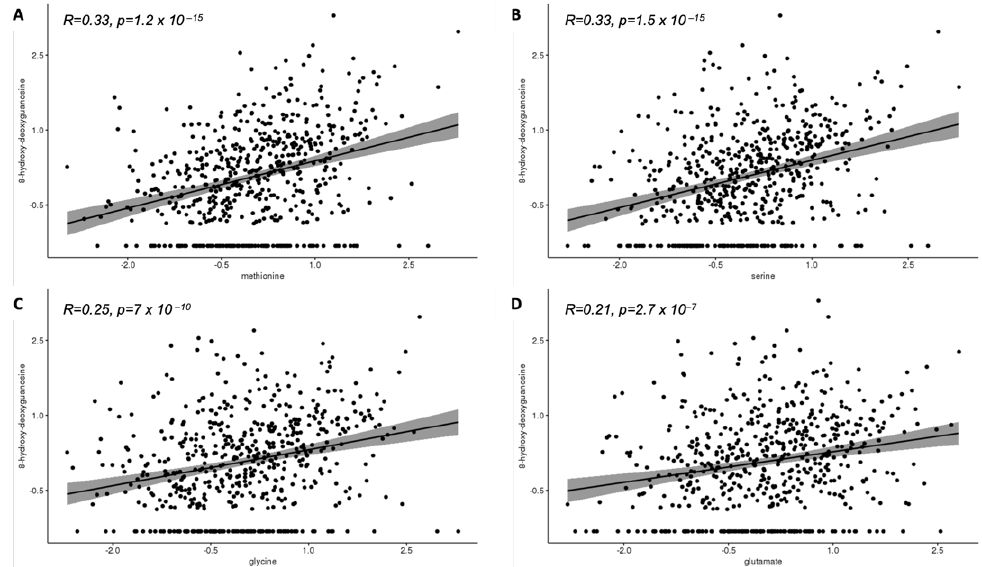
Figure 3. Association of cord plasma methionine ( A ), serine ( B ), glycine ( C ), and glutamate ( D ) with cord plasma 8-hydroxy-deoxyguanosine a . a Inverse normal transformed intensities.